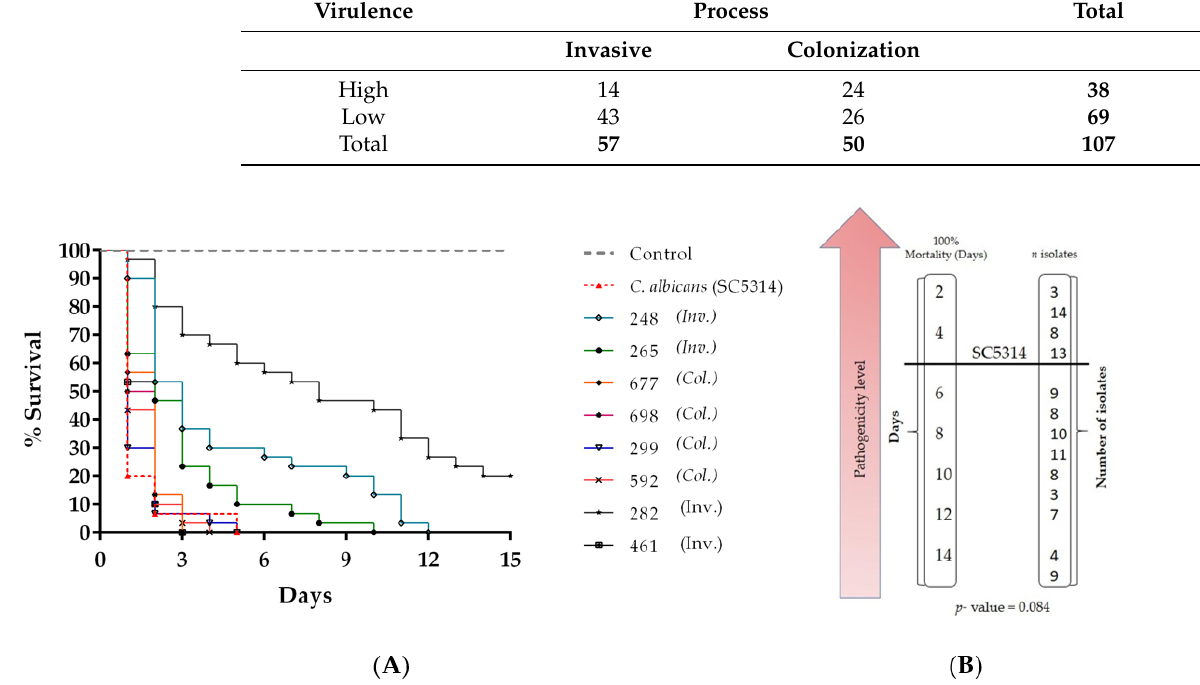
Figure 1. Survival curves of G. mellonella infected with 1 × 10 6 cells/larvae of C. auris and C. albicans ( A ) Kaplan–Meier plots of G. mellonella survival after injection of C. auris from invasive ( Inv. ) and colonization ( Col .) processes compared to C. albicans , which is characterized as high virulence. ( B ) Number of isolates that caused 100% mortality of the larvae in the different days 1–15 of post-infection follow-up compared with strain